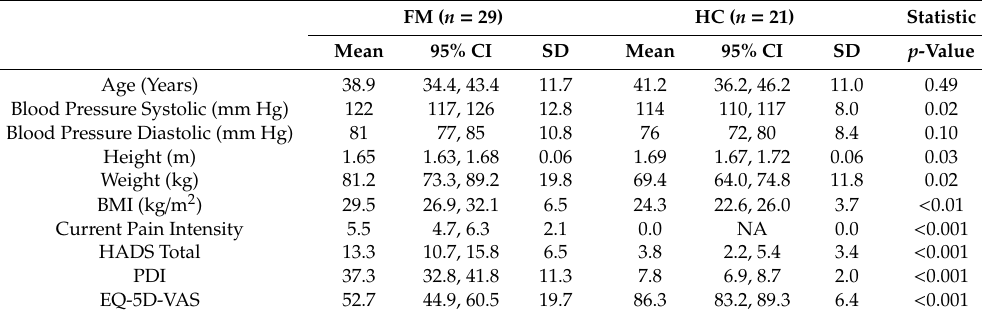
Table 1. Clinical characteristics of the two study